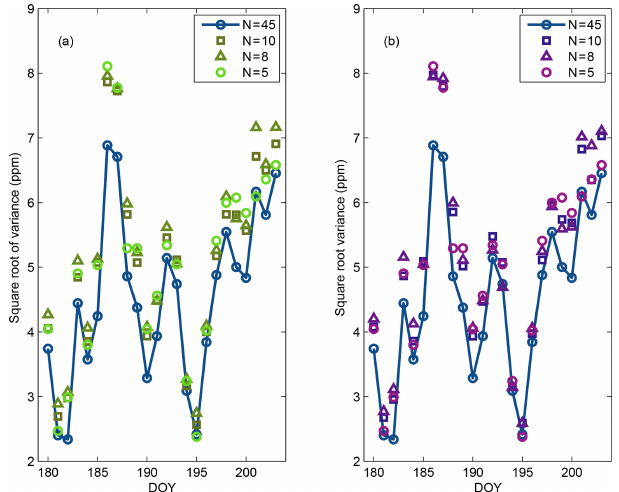
Figure 14. Sum of the CO 2 mixing ratio variance of the large (45- member) ensemble and the different sub-ensembles selected with the SA (a) and GA (b) down-selection techniques.